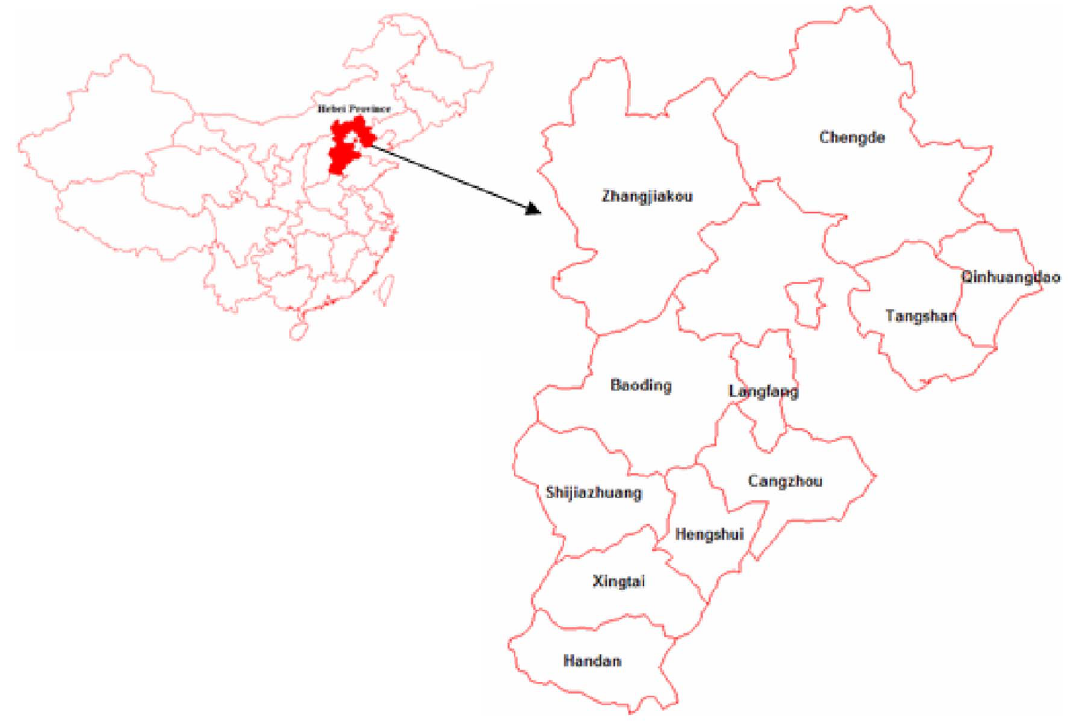
Figure 1. The location of Hebei province.